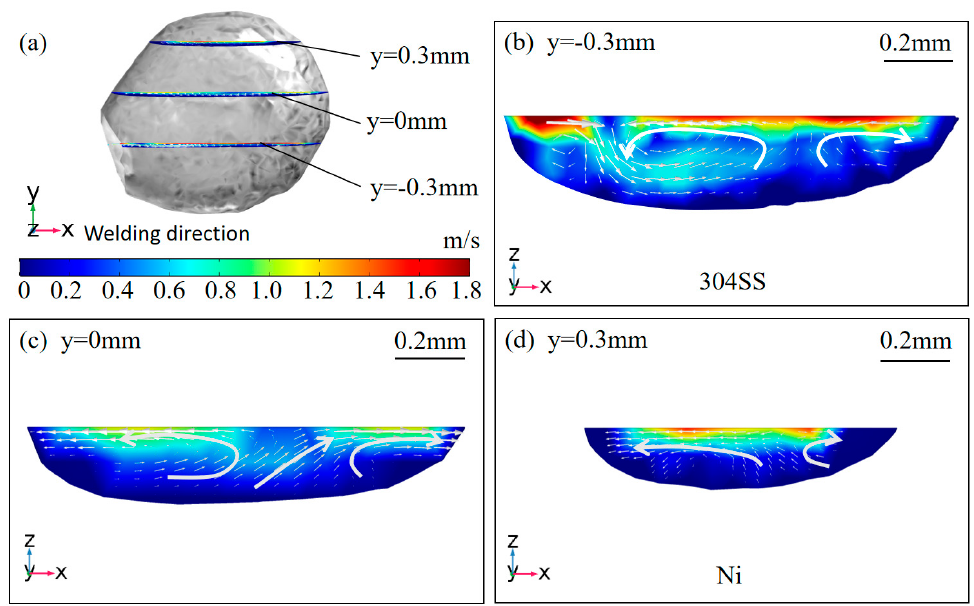
Figure 11. Fluid flow of the molten pool in pure argon for different X–Y sections. ( a ) Overview of sections in the molten pool: ( b ) y = − 0.3 mm; ( c ) y = 0 mm; ( d ) y = 0.3 mm.